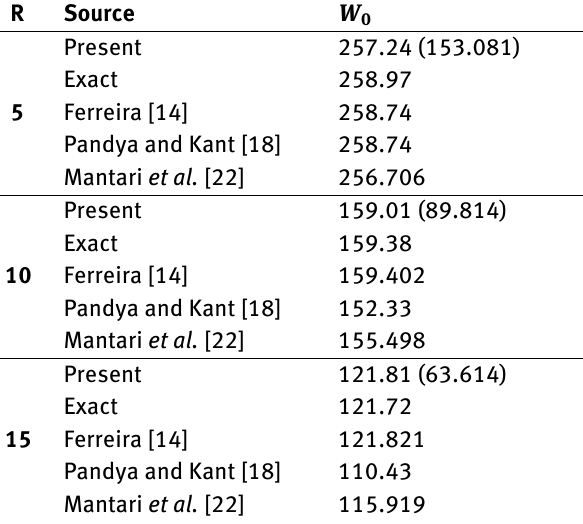
Table 3: Variation of transverse central deflection of simply supported (S2) LCSP and composite plate with stacking sequences and cutouts dimensions